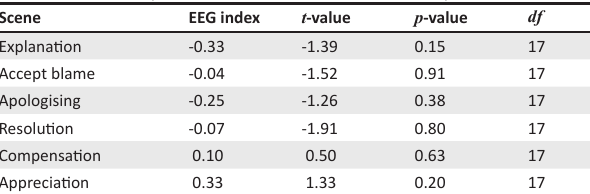
TABLE 3: Male respondents: Less attractive female service provider. Scene